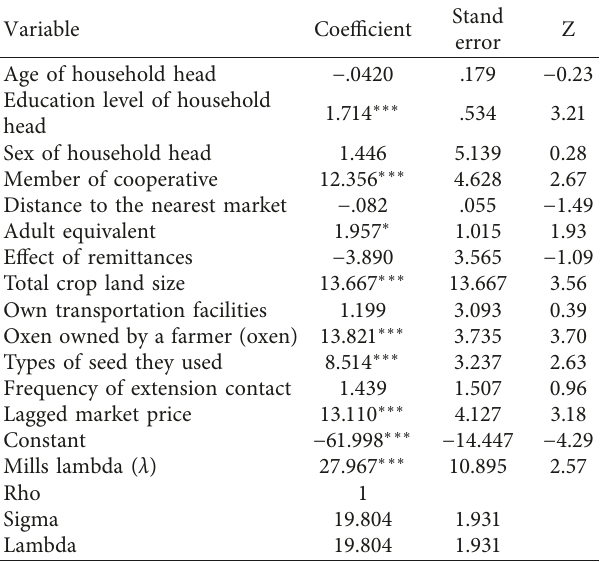
Table 4: Results of the robust Heckman second-stage selection model for potato market